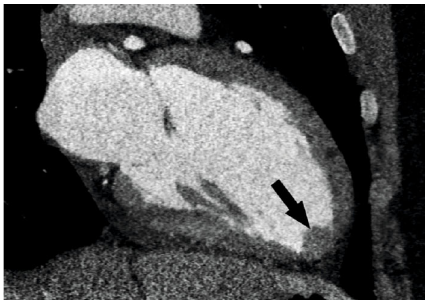
Figure 3: cCTA showing left ventricular apical thrombus.